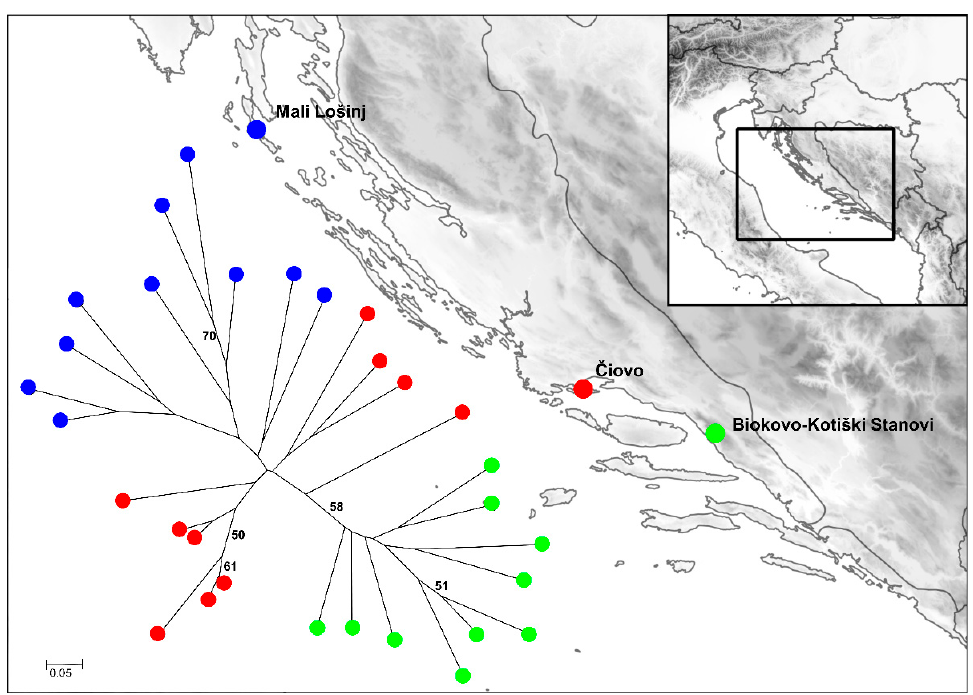
Figure 2. NJ tree based on D PSA between 30 Dalmatian pyrethrum individuals from three distinct populations. Bootstrap values greater than 50% are indicated on the tree.